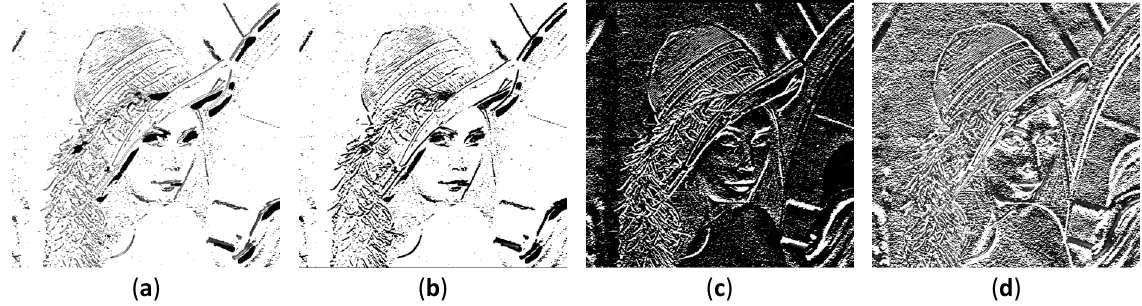
Figure 9. Demonstration using “Lena” to present ( a ) preserved edge pixel image, ( b ) changed edge